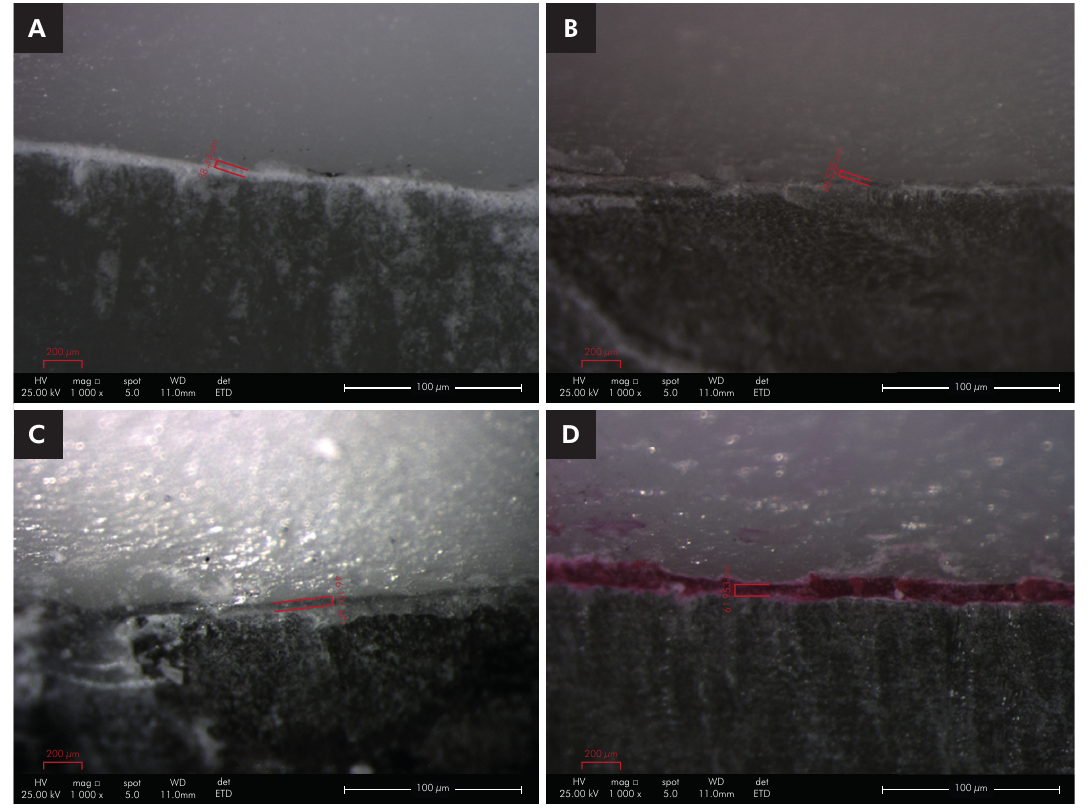
Figure 2. SEM images (40×) of the vestibular marginal discrepancy of GS (a), GP (b), RS (c) and P (d) groups after luting with resin cement. Smaller dimensions of marginal mismatch occurred in the groups in which a glaze layer was applied to the Y-TZP crowns inner surface.